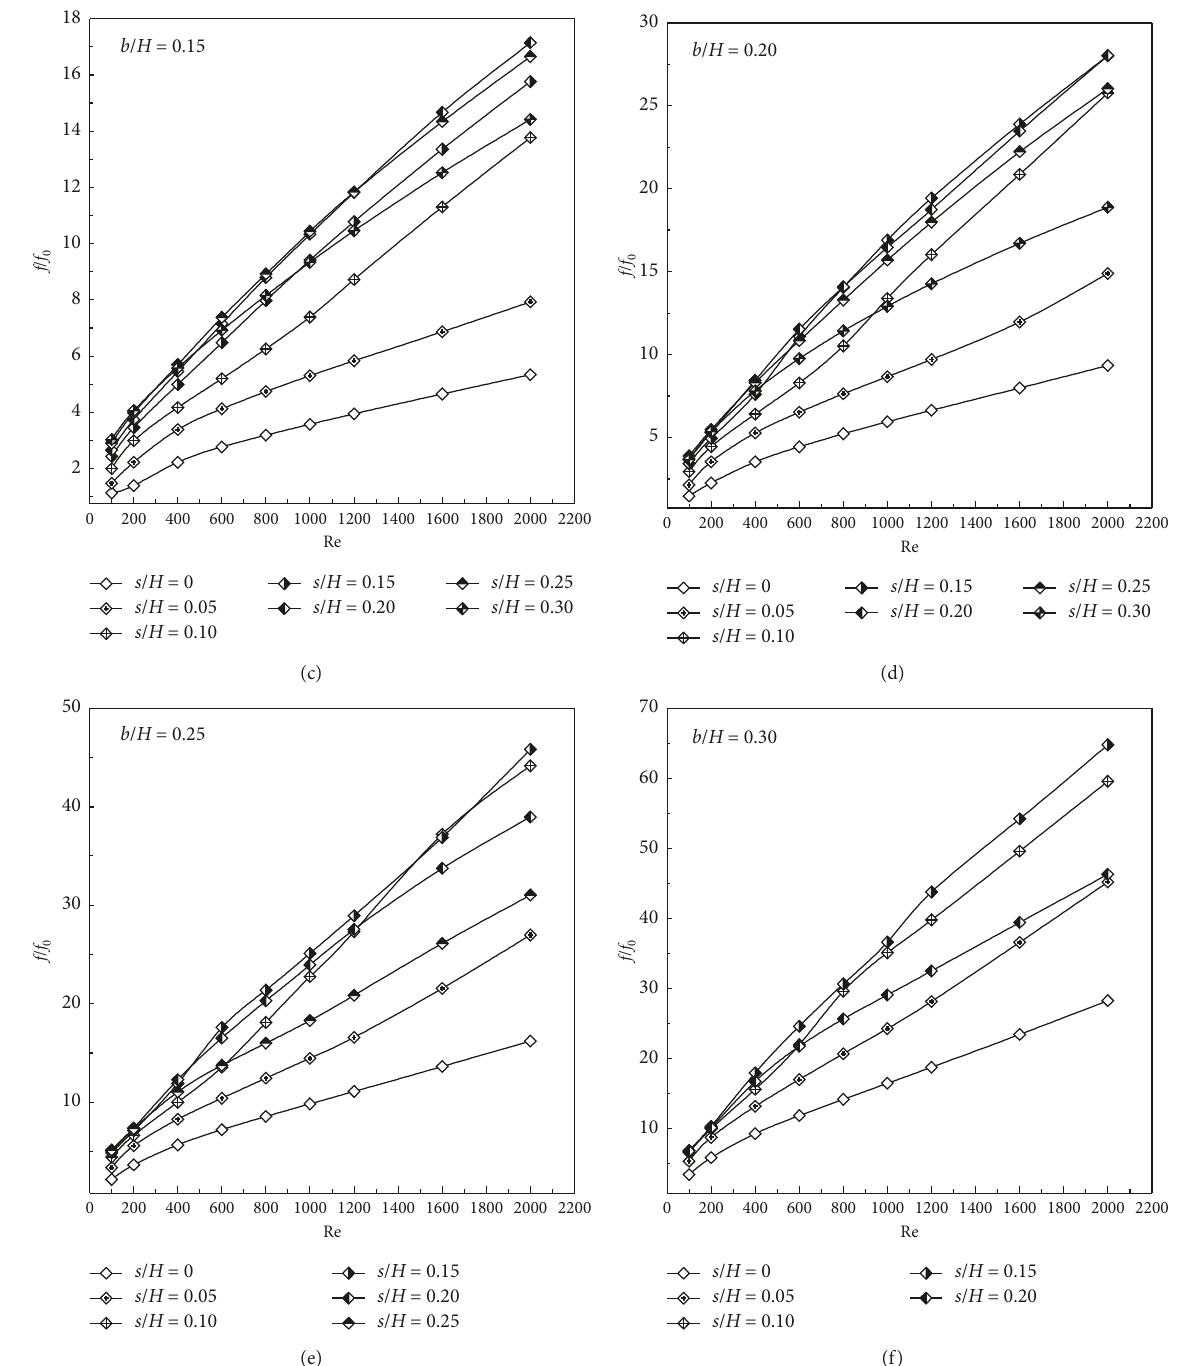
Figure 17: f / f 0 versus Reynolds number for the heat exchanger square duct installed with the 45 H 0.15, (d) b / H 0.20, (e) b / H (cid:31) (cid:31)